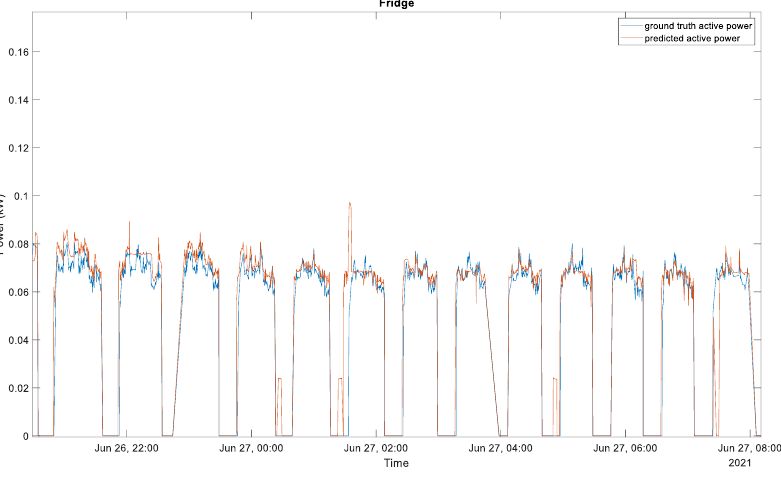
Figure 7. Disaggregation output of the fridge. Blue, ground truth active power; red, predictive active power.